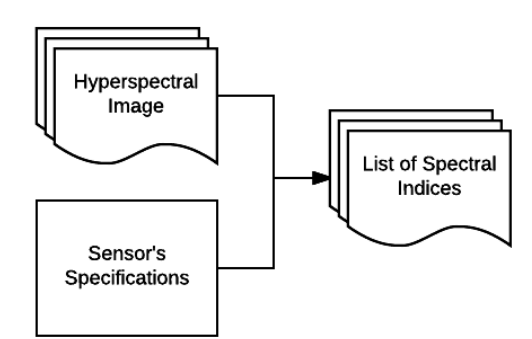
Figure 4. Automatic generation of all available indices which are possible to compute using an image of known